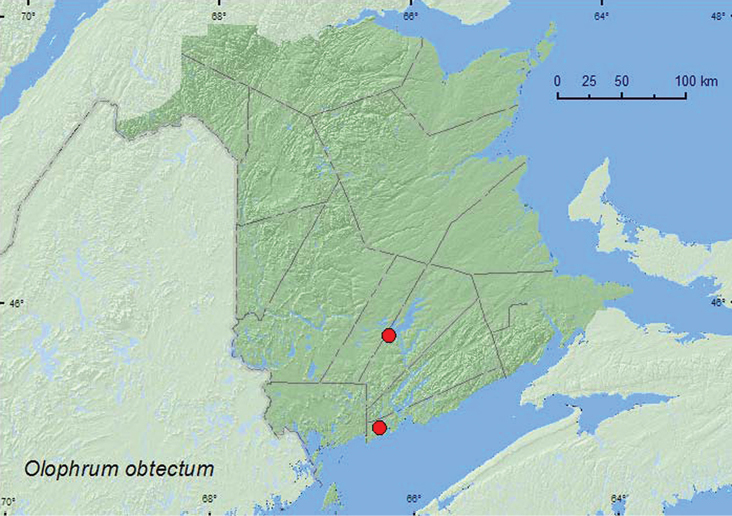
Collection localities in New Brunswick, Canada of Olophrum obtectum.